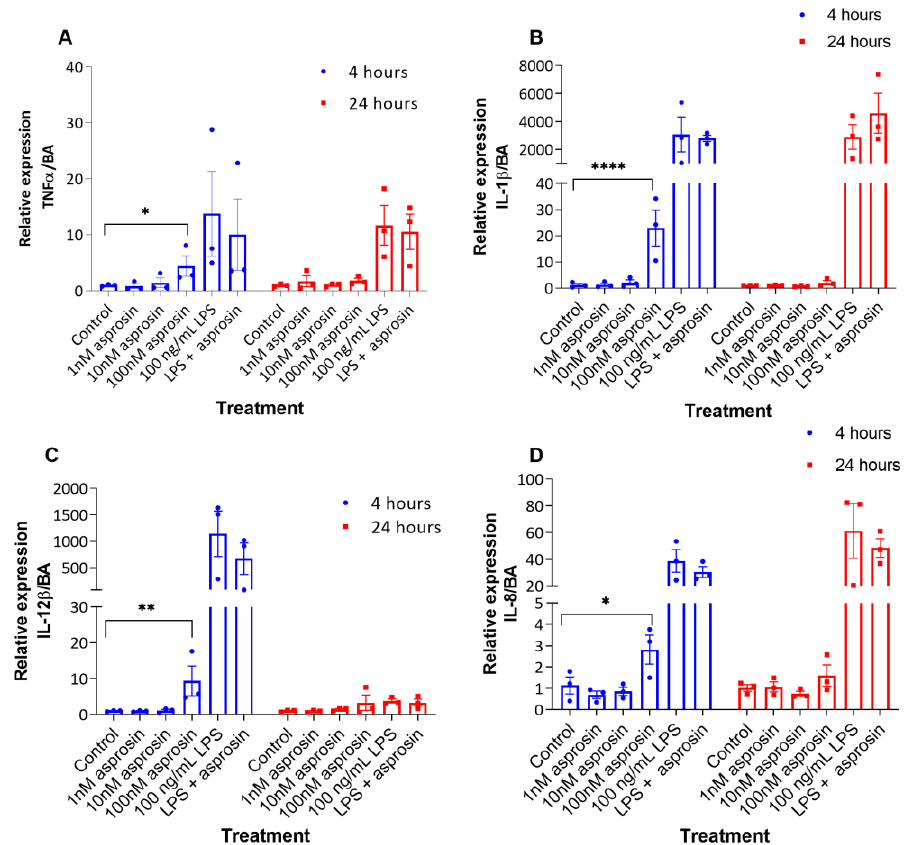
Figure 1. Gene expression of pro-inflammatory cytokines increased after 4 h of treatment with 100 nM asprosin. THP-1 macrophages were treated with increasing concentrations of asprosin (1 nM, 10 nM, and 100 nM), 100 ng/mL lipopolysaccharide (LPS) or both 100 ng/mL and 100 nM asprosin for 4 h and 24 h. ( A ) Tumour necrosis factor α (TNF α ); ( B ) Interleukin-1 β (IL-1 β ); ( C ) IL-12 β ; and ( D ) IL-8 mRNA quantification by RT-qPCR. Values were compared using two-way ANOVA and Tukey’s multiple comparisons test (compared to respective controls). Data are presented as mean ± SEM; n = 3; * p < 0.05, ** p < 0.01; **** p < 0.0001.